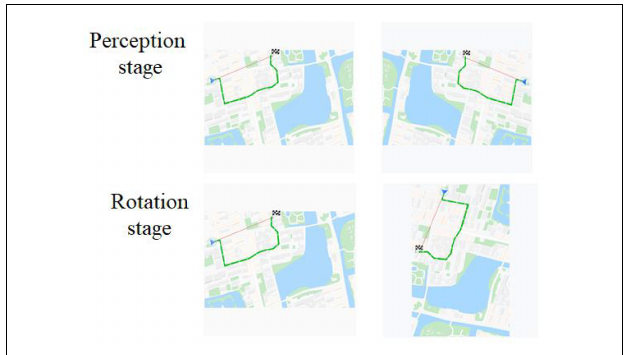
FIGURE 1 | Experimental Materials for object mental rotation. The first column was original images, and the second column was rotation or mirror